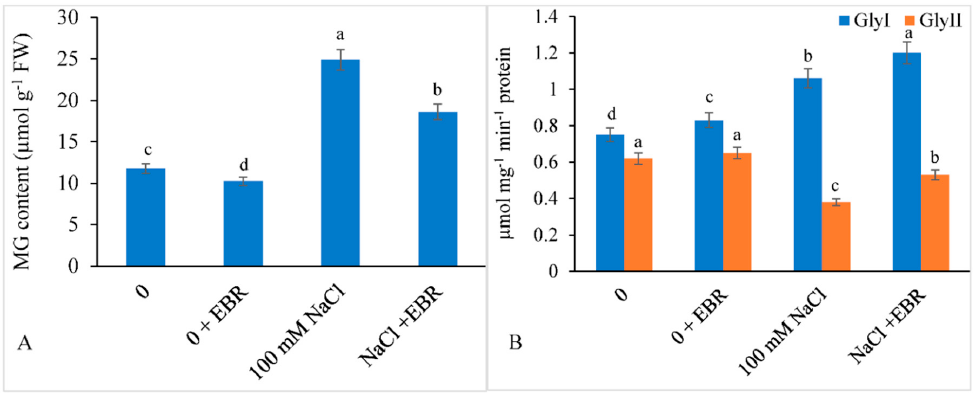
Figure 7. 24-epibrassinolide (EBR) declines methylglyoxal (MG) content ( A ) and enhances GlyI and